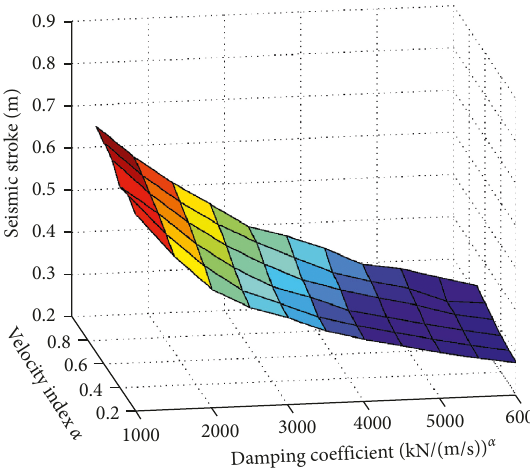
Figure 15: Viscous damper seismic